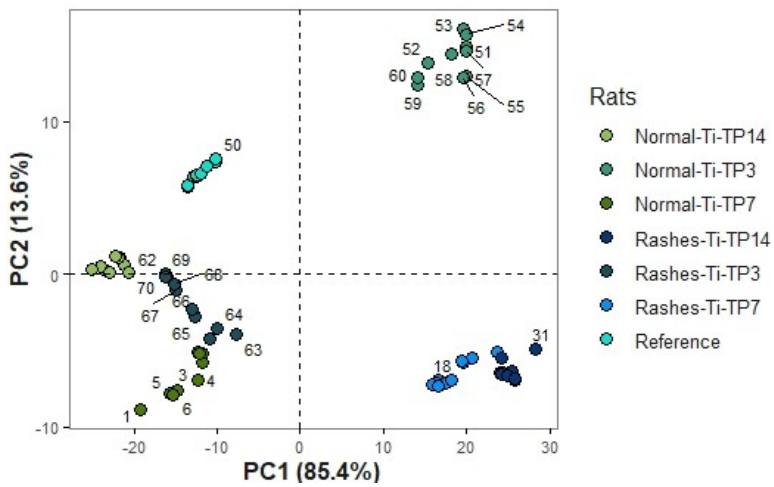
Figure 7. PCA score plot of normal vs. skin rash rats before surgery and on days 3, 7, and 14.